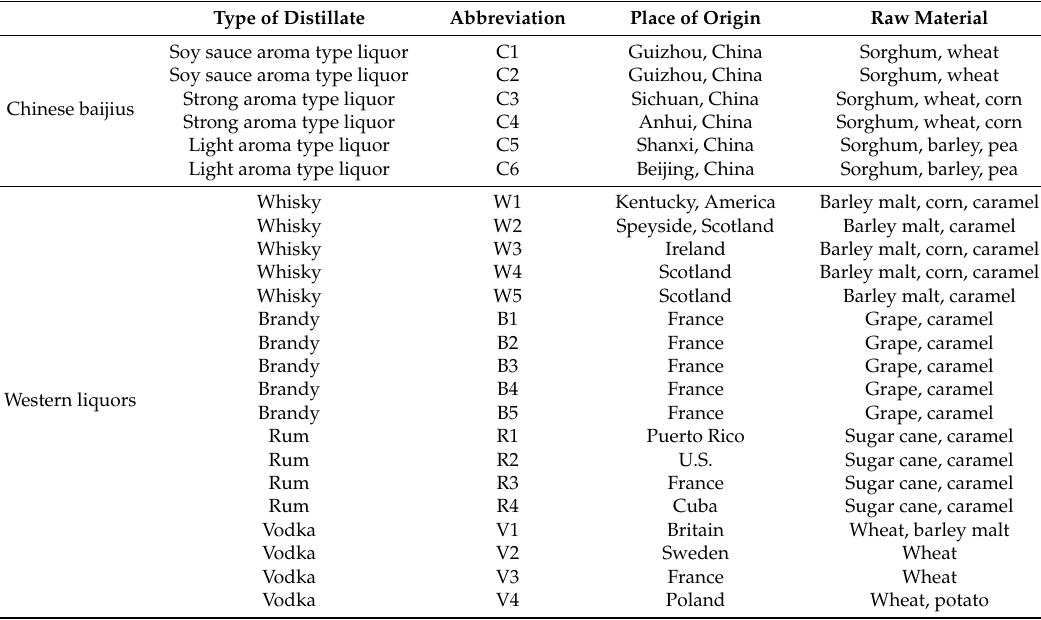
Table 1. Distilled liquors used in this